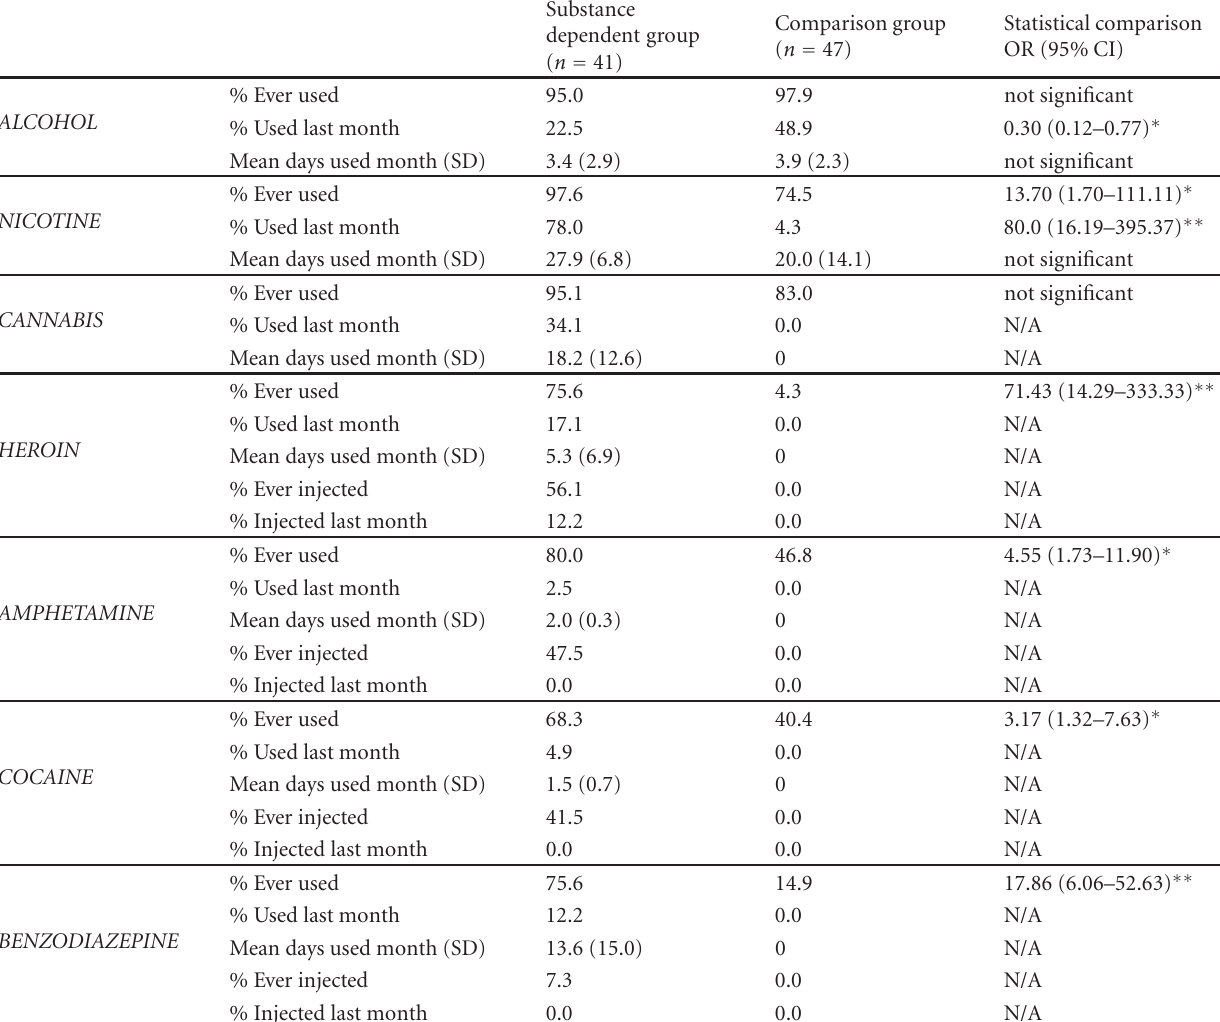
Table 2: Lifetime and 1-month prevalence of substance use among substance-dependent women and comparison